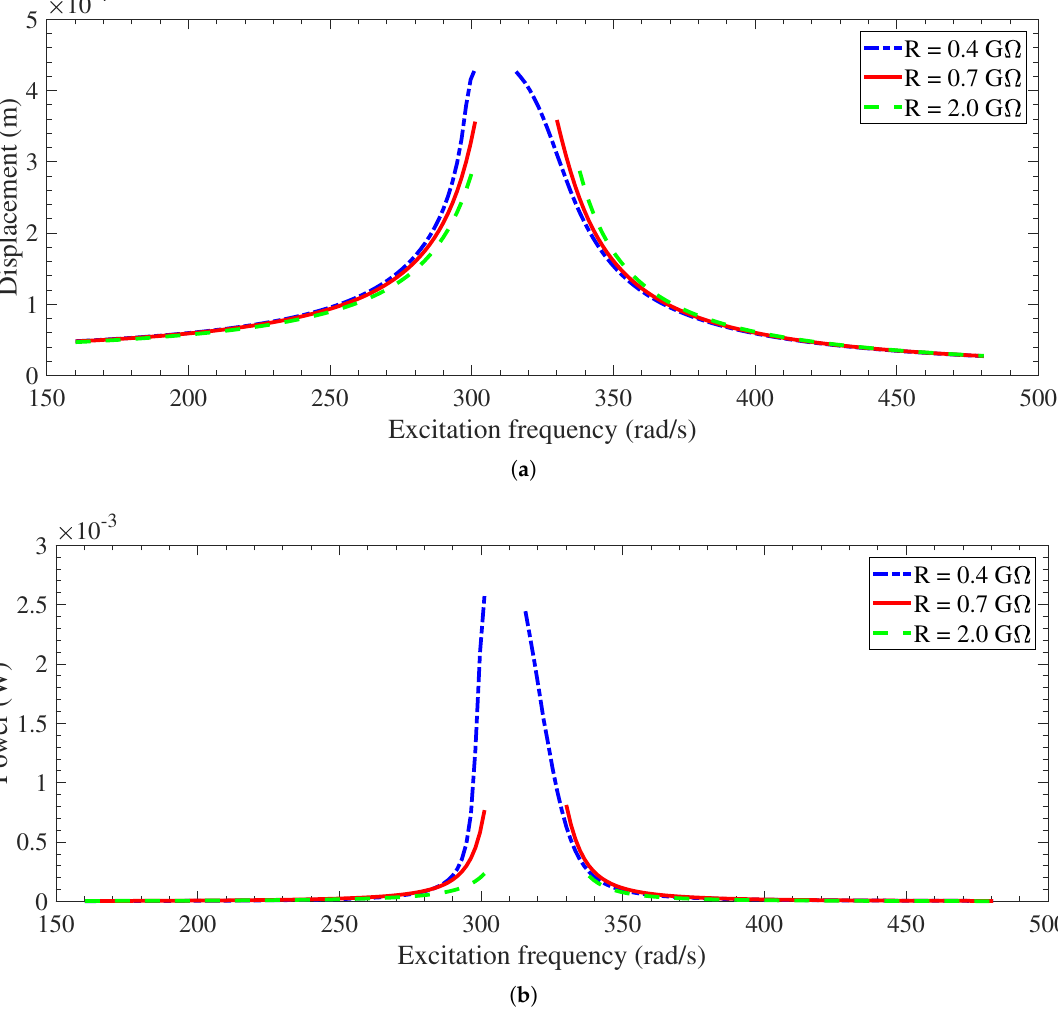
Figure 12. Frequency–response curves in terms of ( a ) displacement and ( b ) electrical harvested power for V et = 1400 V and F = 5 m/s 2